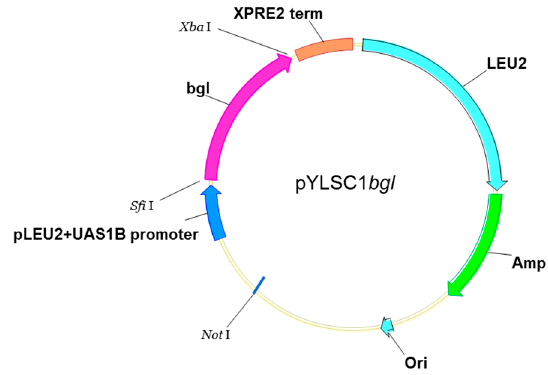
Figure 6. Plasmid map of pYLC1- bgl .